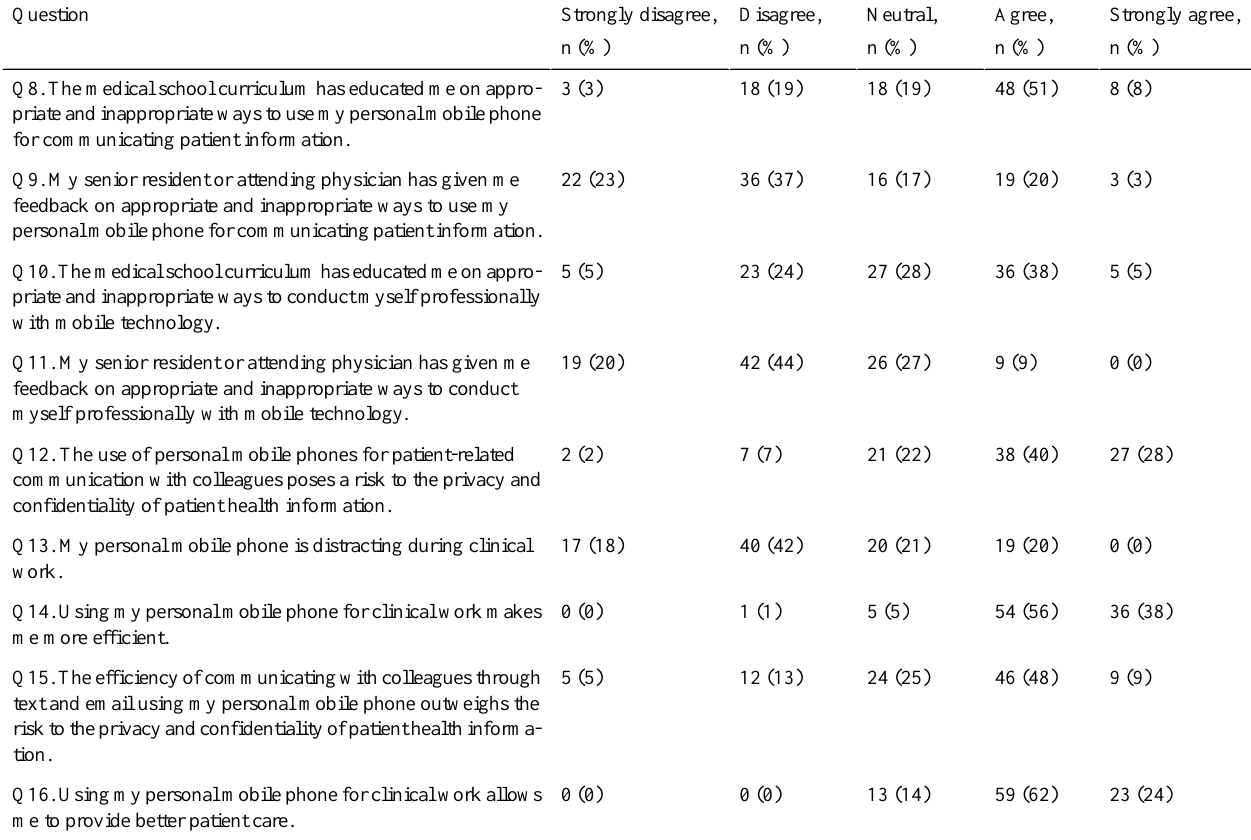
Table 3. Participants’attitudes about using personal mobile technologies for clinical work purposes (n=99) a .